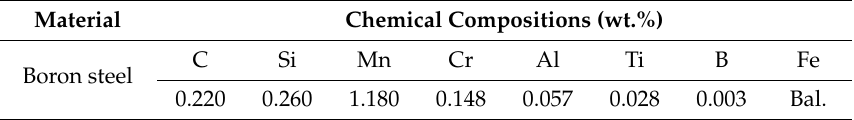
Table 1. Chemical composition of boron steel used in this study.